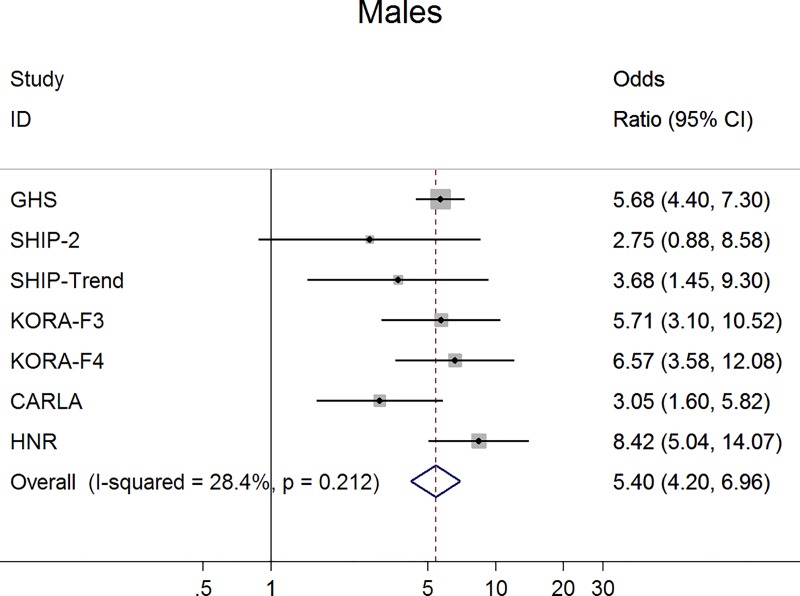
Association between claudication (definition 1) and low ABI in men.